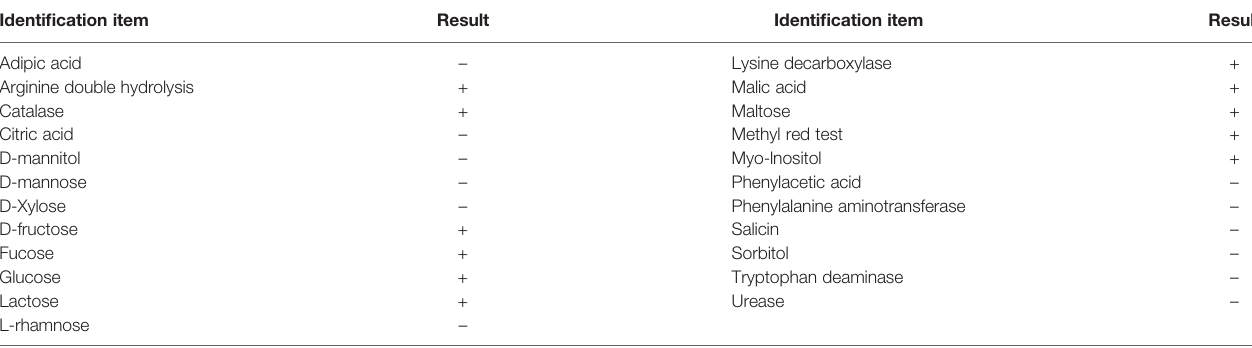
TABLE 1 | Physiological and biochemical identi fi cation of isolated